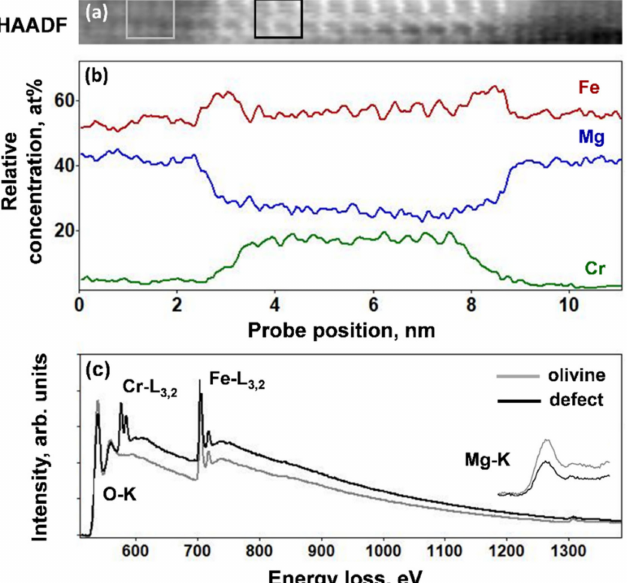
Figure 3. ( a ) Online HAADF image of the thick (100) platelets comparable to the one shown in Figure 2a. ( b ) Relative concentration profiles obtained after curve fitting of the Fe-L3,2 (red), Cr-L3,2 (green), and the Mg-K (blue) electron energy loss spectroscopy (EELS) edges. The profiles show that the platelet is Cr enriched and Mg depleted. The Fe concentration is slightly higher at two/three atomic planes at the interfaces, with respect to the olivine. There is a slight depletion of Mg compared to the olivine. The platelet is Cr enriched. ( c ) EELS spectra from the platelet and the olivine in the energy range between 500 and 1400 eV, where the O-K, Cr-L3,2, Fe-L3,2, and Mg-K EELS edges appear. The spectra were integrated over 180 pixels and extracted from the corresponding spectrum image from the places indicated by the boxes marked in ( a ). Gray box in ( a ) and gray line in ( c ) correspond to olivine and the black ones to the defect. In the inset of ( c ), a magnification on the Mg-K edge in between 1280 and 1340 eV is